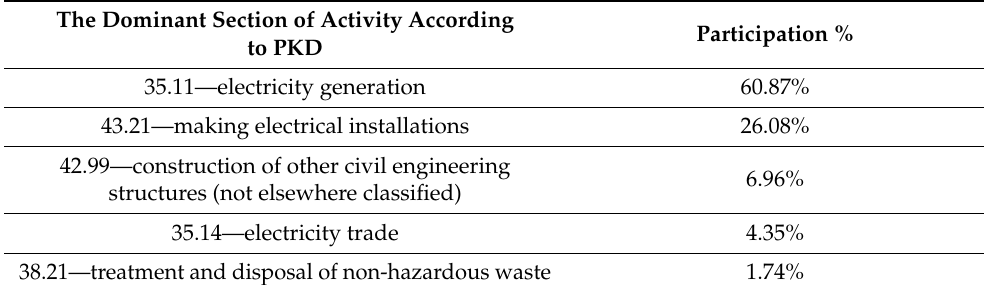
Participation % 6.96%